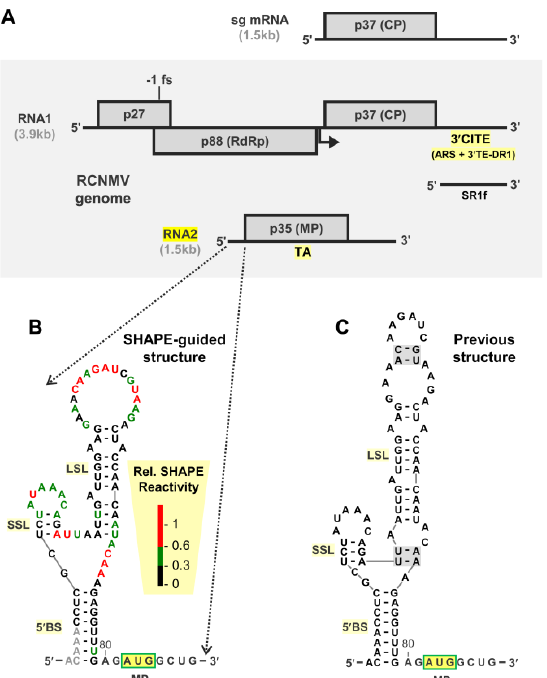
Figure 1. RCNMV genome and 5 ′ UTR structure for RNA2. ( A ) RCNMV genome organization. Structures of RCNMV RNA1 and RNA2 genome segments are shown in the shaded box. Nucleotide lengths are provided in kilobases (kb), and encoded proteins are depicted as rectangles with their corresponding sizes indicated in kilodaltons. The positions of the 3 ′ cap-independent translation element (3 ′ CITE), the adenine-rich sequence (ARS), and the 3 ′ translation element of dianthovirus RNA1 (3 ′ TE-DR1) in RNA1 are shown. The location of the trans-activator (TA) in RNA2 is indicated. The transcription initiation site for the sg mRNA in RNA1 is indicated by the angled arrow with the sg mRNA shown above. ( B ) SHAPE-guided model for the 5 ′ UTR of RCNMV RNA2. The 5 ′ -basal stem structure (5 ′ BS), small stem loop (SSL), and large stem loop (LSL) are labeled. Reactivity of color-coded nucleotides in the structure correspond to the relative levels depicted in the key. Grey bases denote null reactivity values. ( C ) Secondary RNA structural model of the 5 ′ UTR of RCNMV RNA2 generated through computational energy minimization [27].